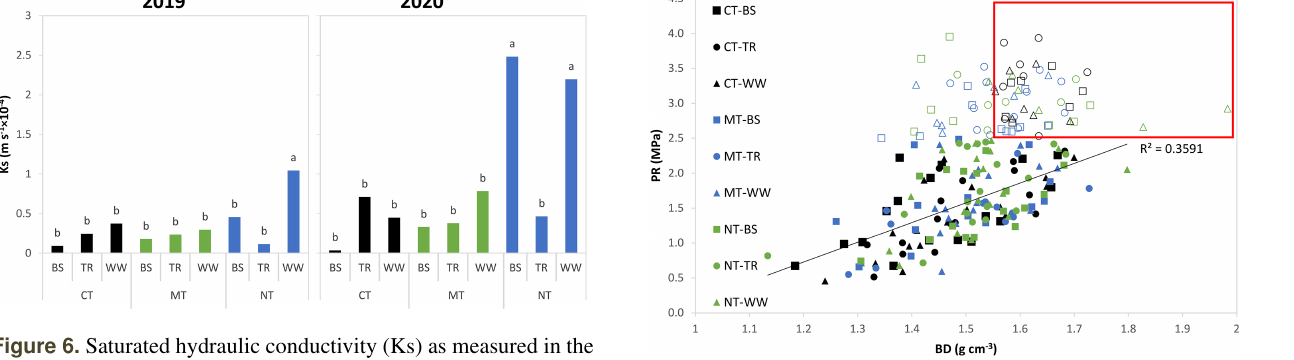
Figure 8. Correlation between bulk density (BD) and penetration resistance (PR). The line represents the significant ( p < 0 . 01) lin- ear correlation for PR < 2.5MPa and BD < 1.8gcm − 3 . Closed and open symbols are used for PRs below or above 2.5MPa, respec- tively. The red box highlights observations above both 1.55gcm − 3 BD and 2.5MPa